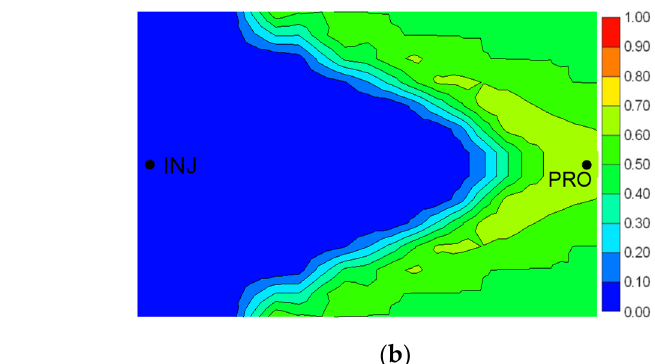
Figure 6. Mass fraction distribution of components of oil after steam flooding. ( a ) Mass fraction distribution of heavy components. ( b ) Mass fraction distribution of light components.